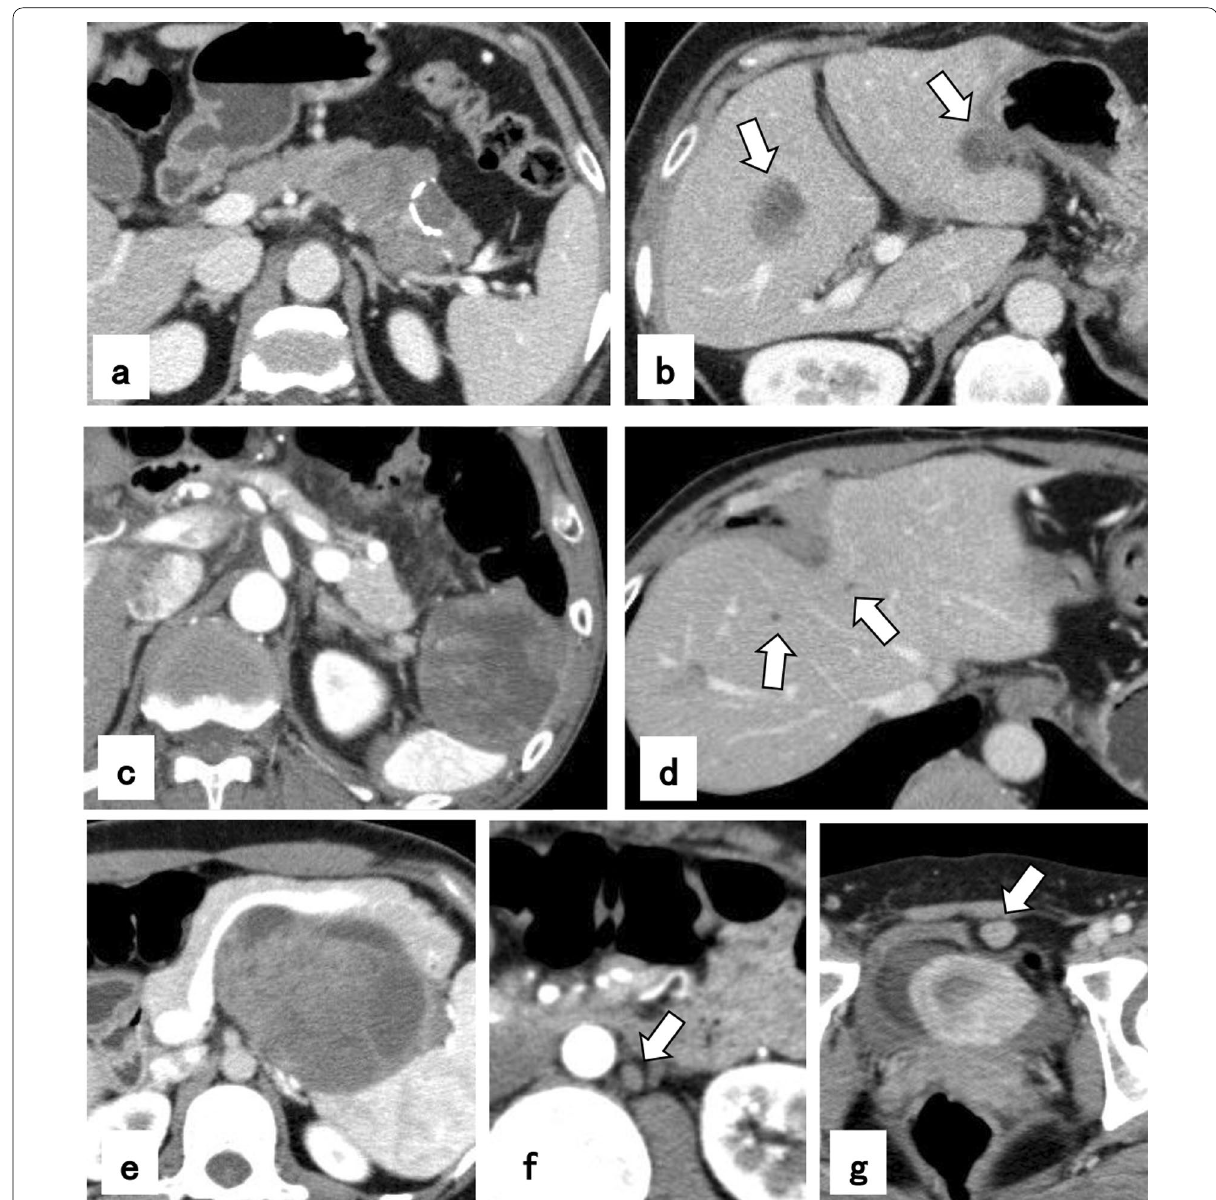
Fig. 1 a Computed tomography (CT) image of the primary tumor in a solid pseudopapillary neoplasm (SPN) (Patient No. 1). b CT image of liver metastases 10 months after resection of the primary tumor (Patient No. 1). c CT image of the main tumor in SPN (Patient No. 2). d CT image of multiple liver metastases 9 months after resection of the primary tumor (Patient No. 2). e CT image of the primary tumor in SPN (Patient No. 3). f CT image of synchronous para-aortic lymph node metastasis (Patient No. 3). g CT image of peritoneal wall metastasis in the anterior wall of the urinary bladder (Patient No.